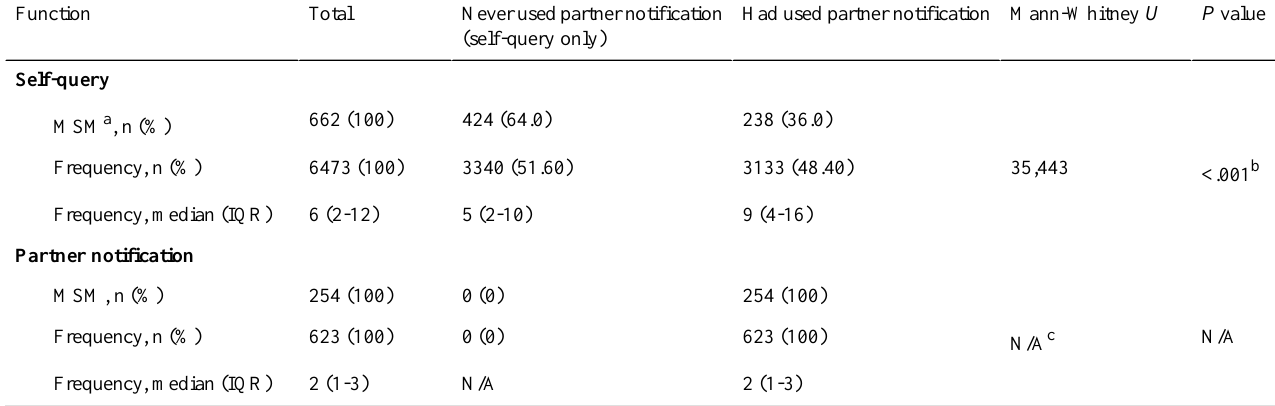
Table 1. Usage frequency of functions by the app users.